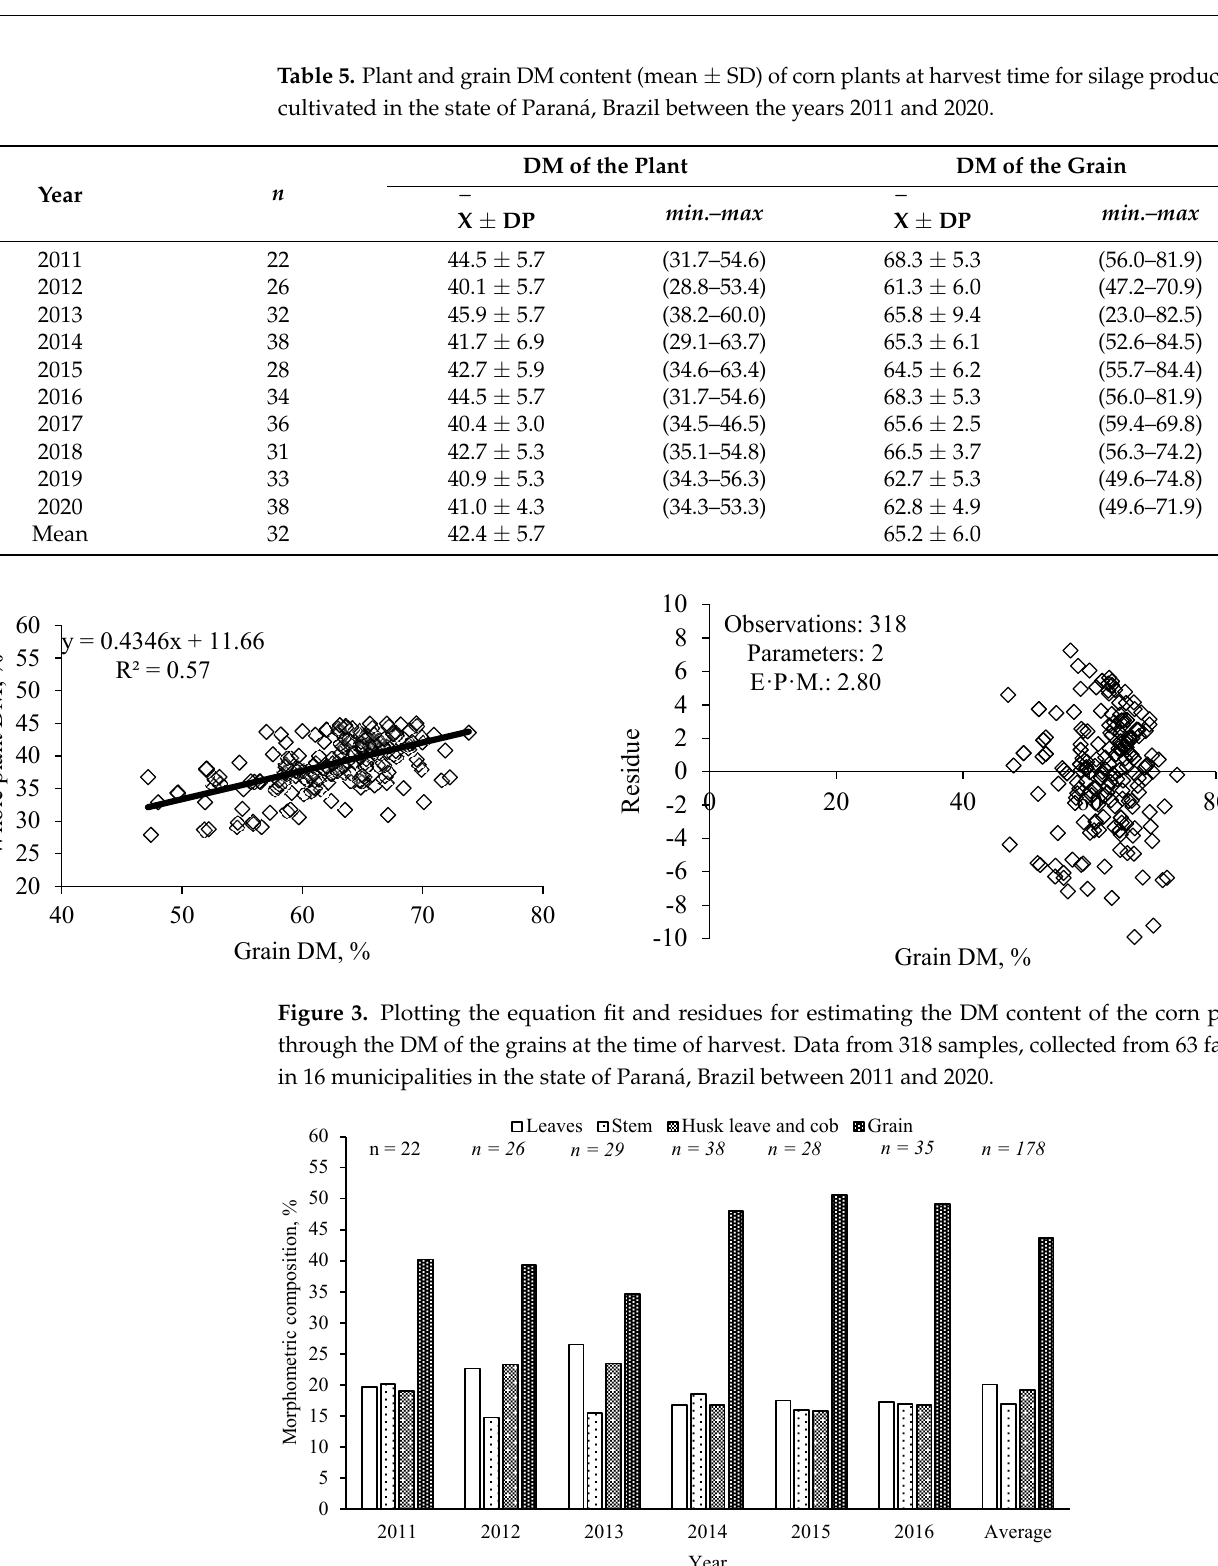
Figure 4. Centesimal morphometric composition of the corn plant from crops cultivated for silage production in the state of Paraná, Brazil between the years 2011 and 2016. The average fresh biomass yield was 56,913 kg ha − 1 , with variations in averages between the years from 55,965 to 66,813 kg ha − 1 (Table 6). Among the minimums and maximums observed each year, yields ranging from 31,440 to 89,004 kg ha − 1 are